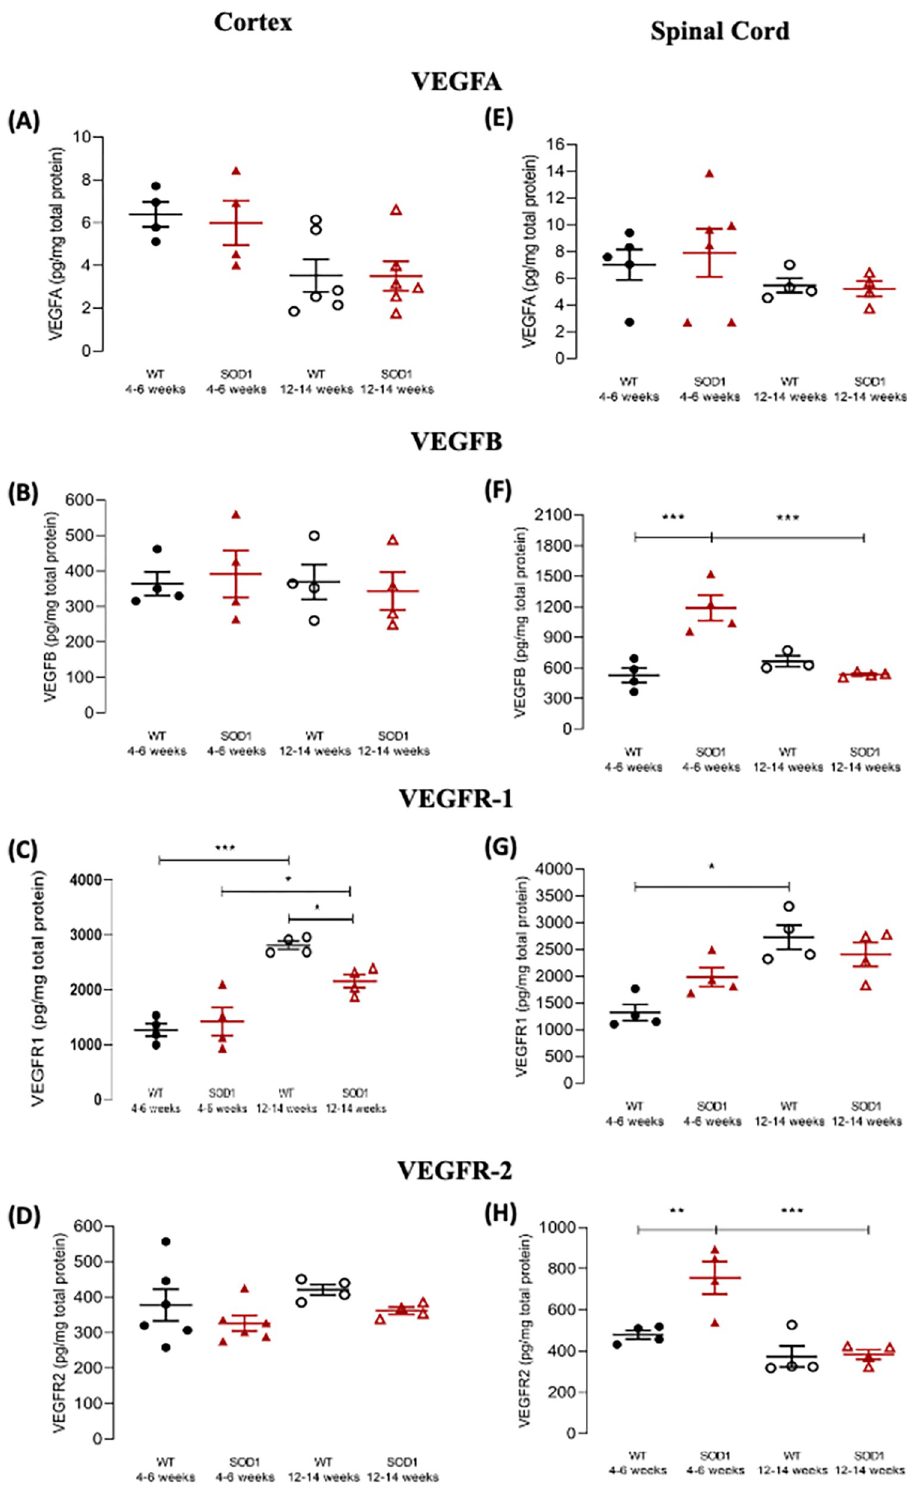
Fig 3. VEGF and VEGF receptor protein levels in the cortex and spinal cord of pre-symptomatic and symptomatic SOD1 G93A mice. (A-D) Data from cortical samples; (E-H) data from spinal cord samples. VEGFA (A, E), VEGFB (B, F) , VEGFR-1 (C, G) or VEGFR-2 (D, H) protein levels, determined by ELISA, in samples from pre-symptomatic (4–6 weeks old) or symptomatic (12–14 weeks old) SOD1 G93A and age-matched WT mice, as indicated below each data